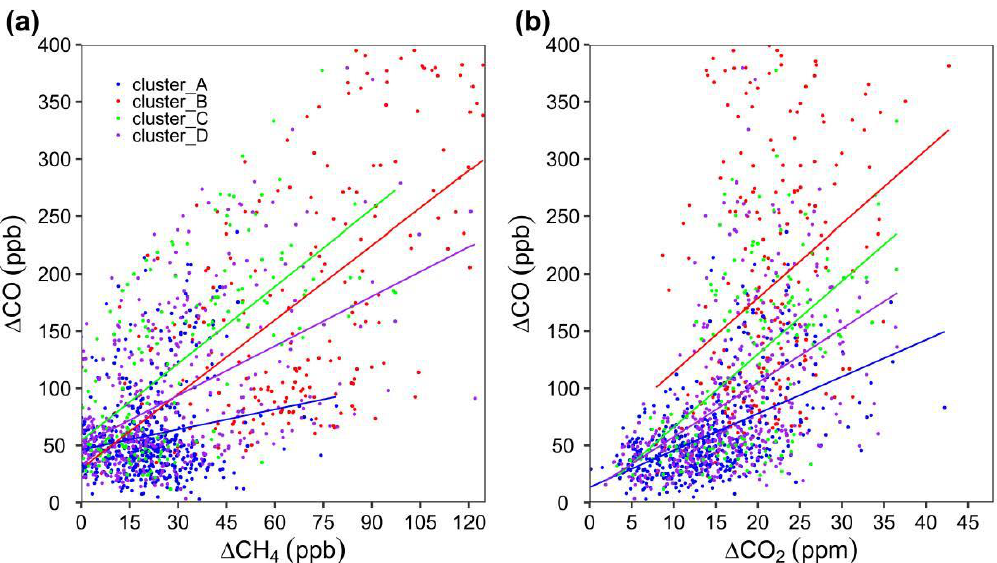
Figure 9. Average CO 2 ( a , b ), CH 4 ( c , d ), and CO ( e , f ) concentrations associated with each cluster. Box plots indicate the median and inter-quartile range.